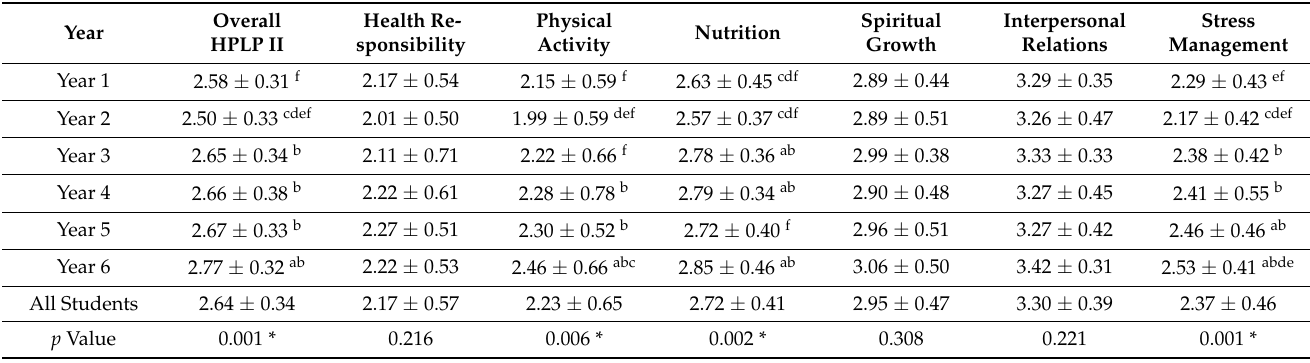
Table 3. Health-Promoting Lifestyle Profile II (HPLP II) scores according to the academic